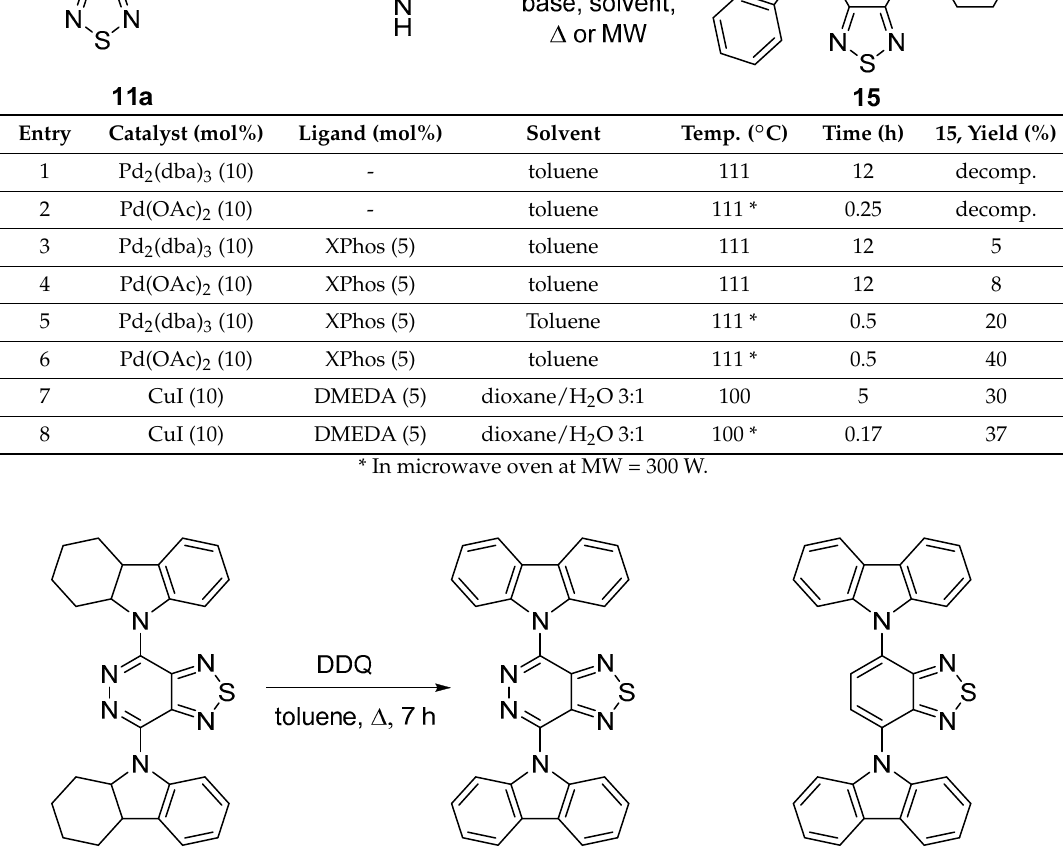
Figure 1. Dimers in the crystal of 16 in representation of atoms by thermal ellipsoids (p = 50%).